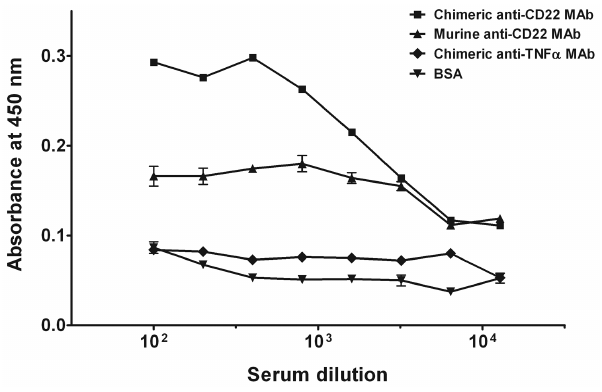
Figure 1. Serum titer evaluation of idiotype antibody-immu- nized mouse. The BALB/c mouse was immunized with anti-CD22 SM03 as described in Methods. Serum was collected at the fourth day after the second boost dose, and serum titer was evaluated by ELISA. Antigens (0.1 m g/well) that were coated onto the ELISA plate are chimeric anti-CD22 MAb ( & ), murine anti-CD22 MAb ( m ), chimeric anti- TNF a MAb ( X ), and BSA ( . ). Results are expressed as means 6 SEM of duplicates. Data shown is a representative of three separate experi-